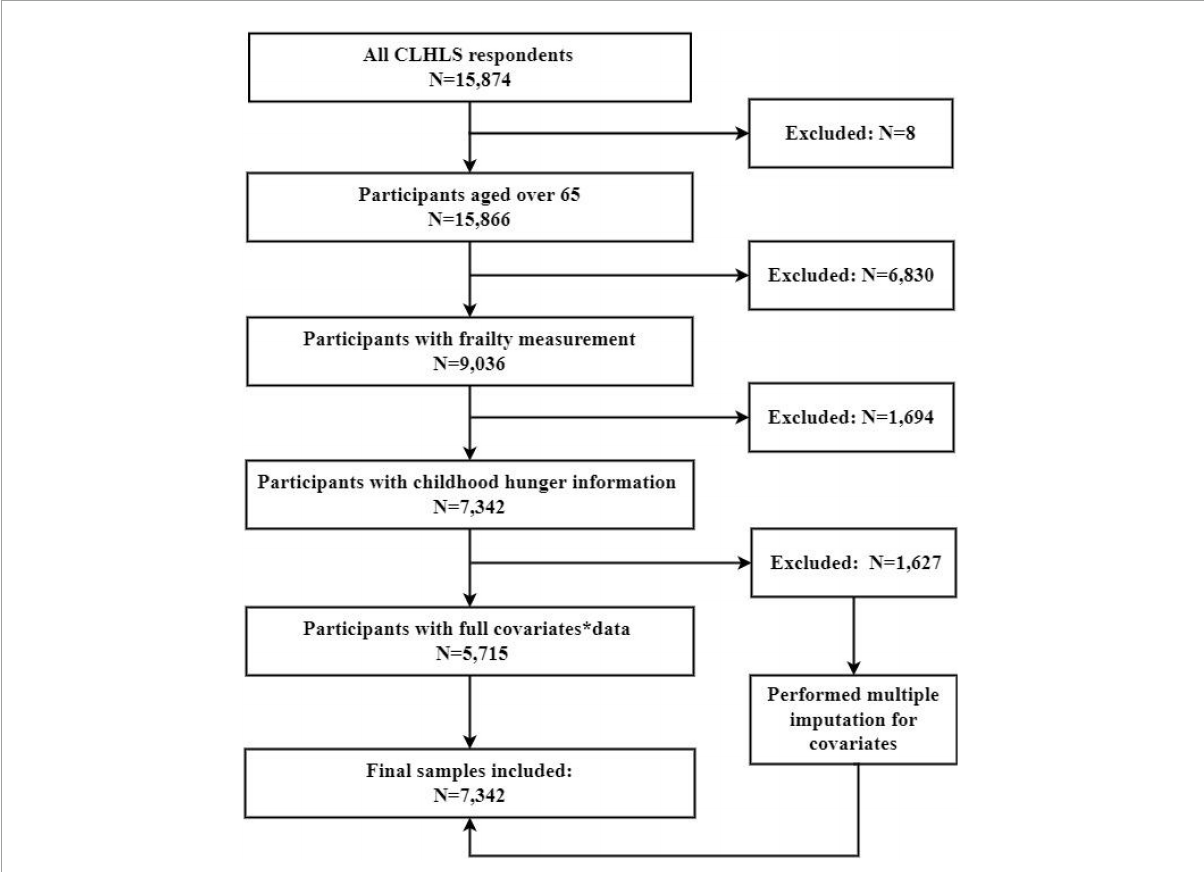
FIGURE1 Flowchart on the sample selection and exclusion. *Covariates: residence, marriage, living arrangements, education, occupation, smoking, drinking, exercise, social and leisure activity index, dietary pattern, and nutrition status, financial support, insurance status.